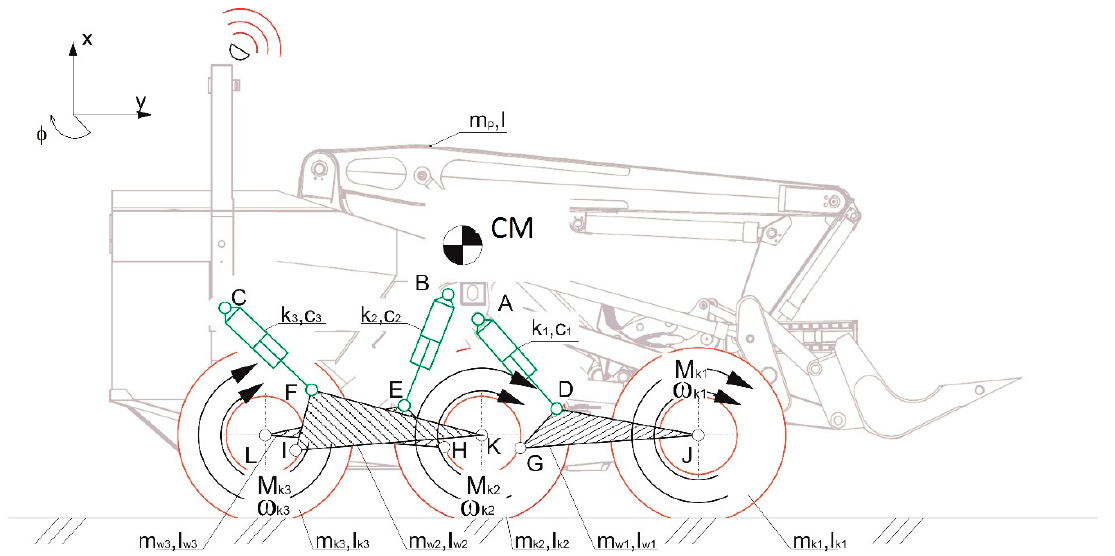
Figure 4. Structure and main parameters of half vehicle multi-body model. Table 1. Values of main vehicle body